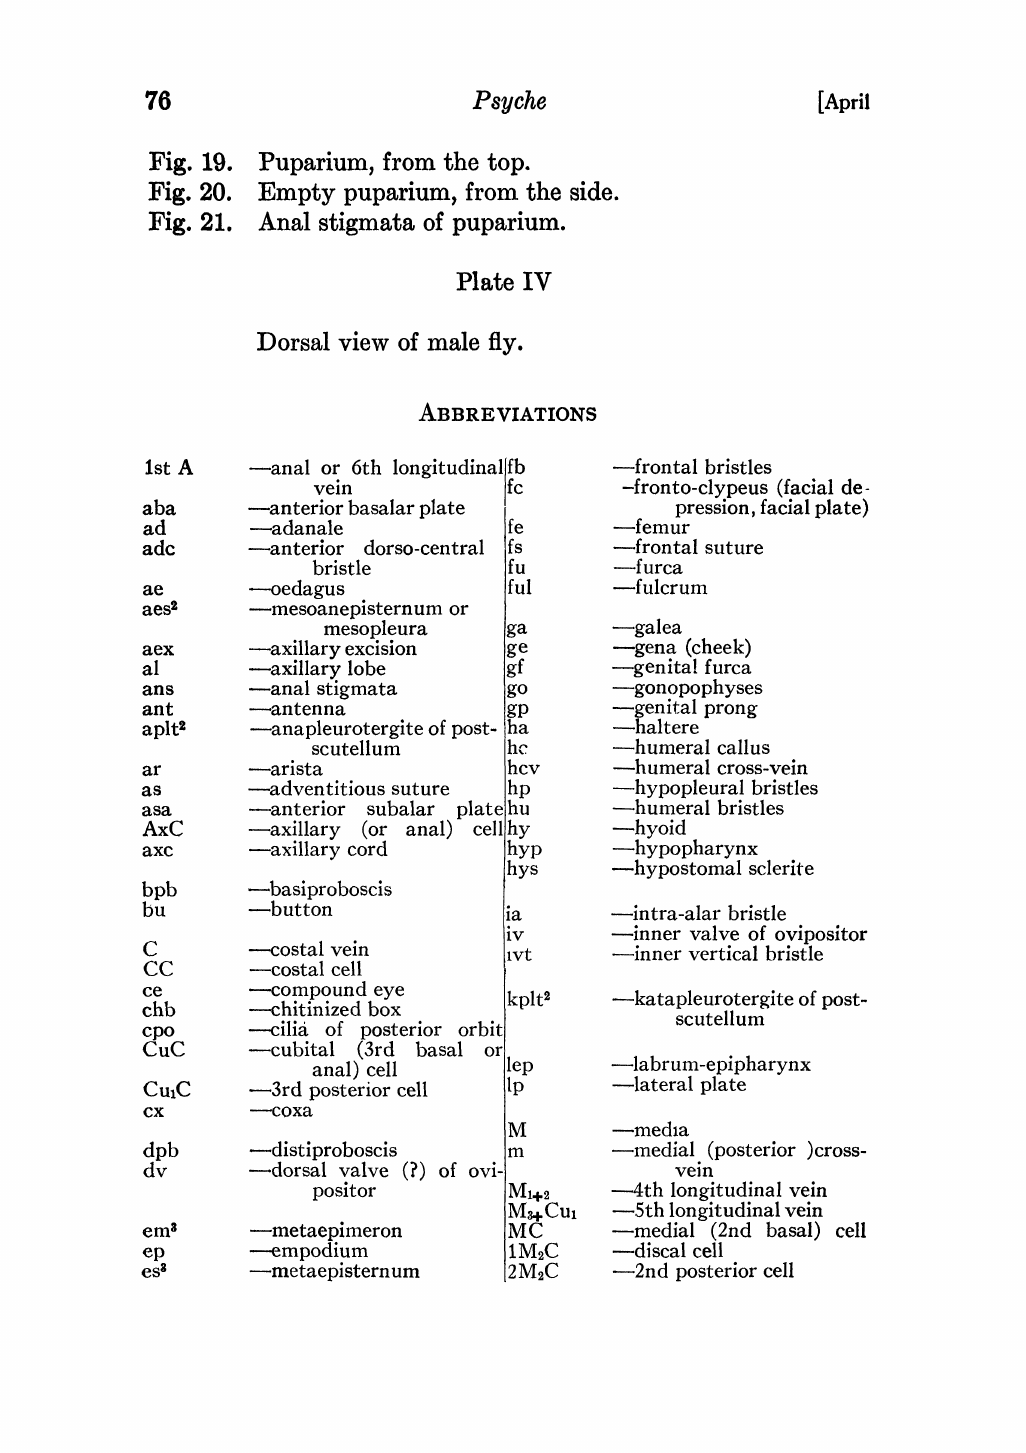
Psyche Puparium, from the top. Empty puparium, from the side. Anal stigmata of puparium. Plate IV Dorsal view of male